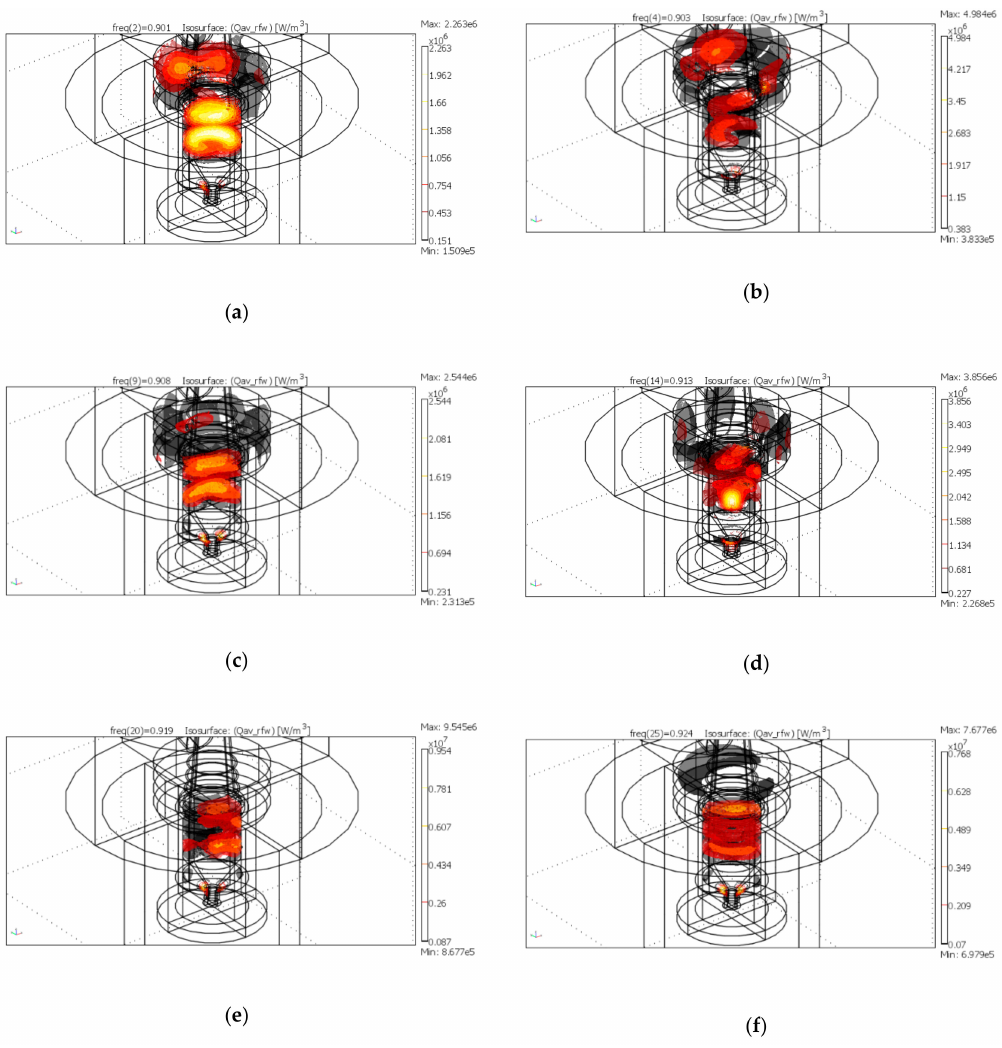
Figure 9. Power density distribution in the load and in the 3 refractory rings at the frequency of: ( a ) 901 MHz; ( b ) 903 MHz; ( c ) 908 MHz; ( d ) 913 MHz; ( e ) 919 MHz; ( f ) 924